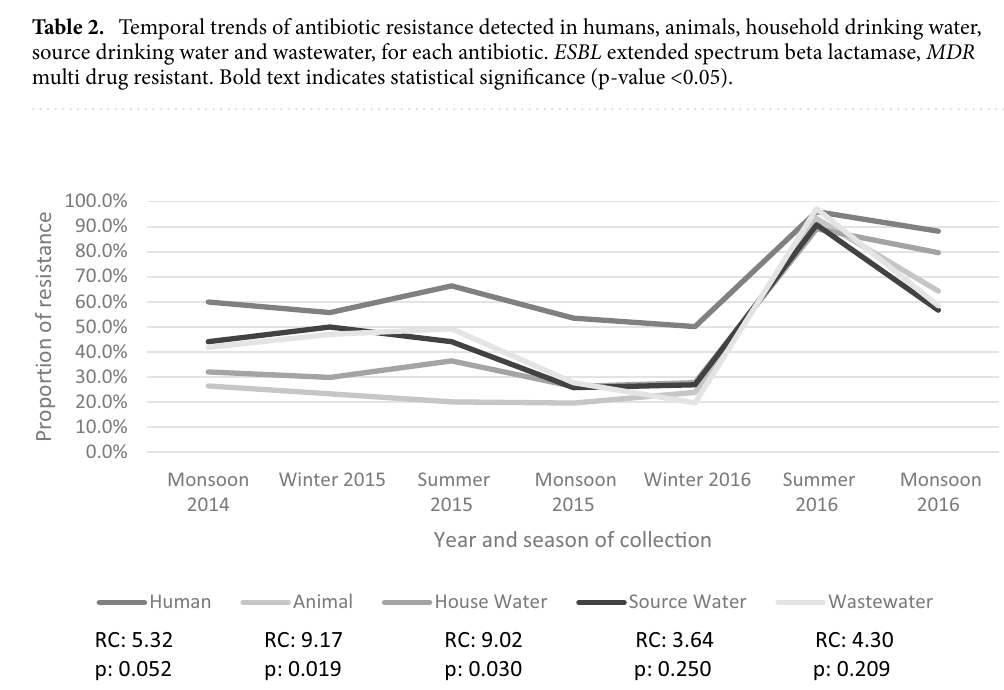
Figure 3. Line graph of over time trend of percentage of resistance to ampicillin, with regression coefficients and p -value for Newey–West analyses. RC Regression Coefficient p = p